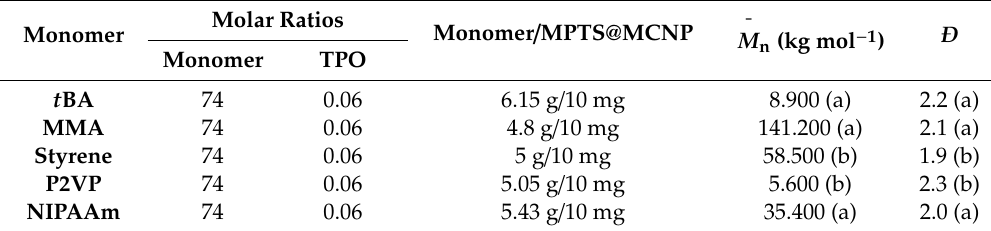
Figure 4. SEC elution traces (DMAc / LiCl) of polymers synthesized by free radical polymerization in the presence of MPTS@MCNP as chain transfer agent: red line: P t BA ( M n = 8.900 kg mol − 1 ; Ð = 2.2); green line: PMMA ( M n = 141.200 kg mol − 1 ; Ð = 2 .1); blue line: PS ( M n = 58.500 kg mol − 1 ; Ð = 1.9); cyan line: P2VP ( M n = 5.600 kg mol − 1 ; Ð = 2.3); pink line: PNIPAAM ( M n = 35.400 kg mol − 1 ; Ð = 2.0). Table 1. Composition of di ff erent reaction mixtures for the free radical polymerization of di ff erent monomers in the presence of MPTS@MCNP as chain transfer agent, and SEC-results for the obtained